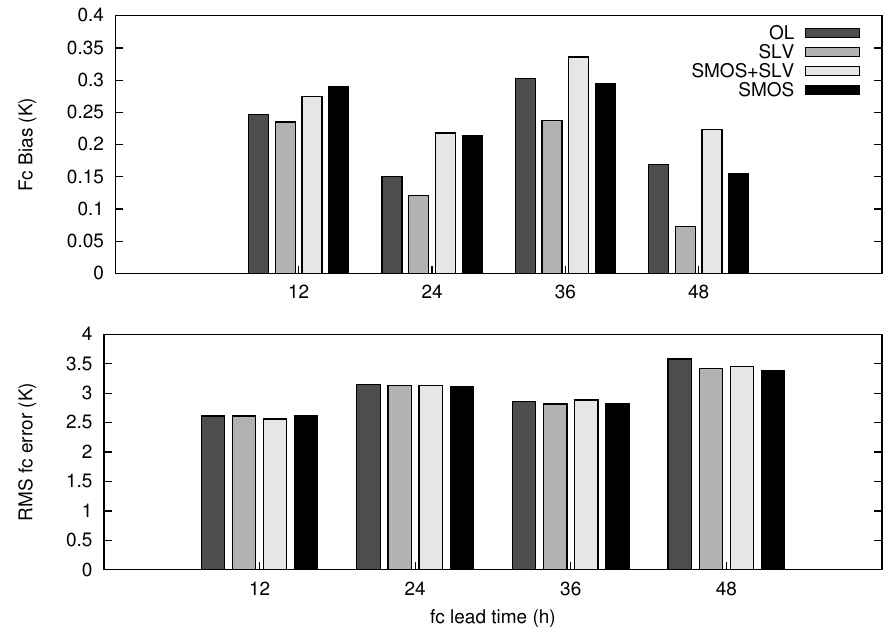
Figure 7. Averaged forecast biases and RMS forecast errors of 2 m dew point temperature compared to observations of the SYNOP network in North America, as a function of the forecast lead time for the four experiments of Group I.